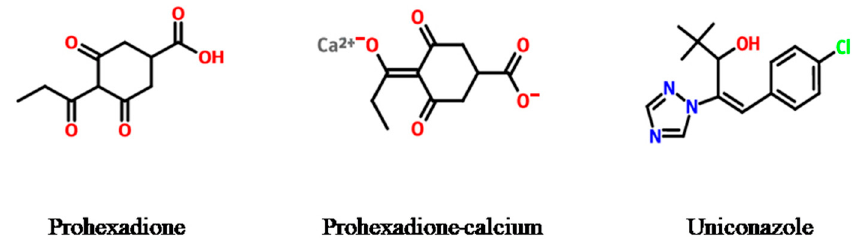
Figure 1. Chemical structure of plant growth regulators (prohexadione, prohexadione-Ca, and uni- conazole).